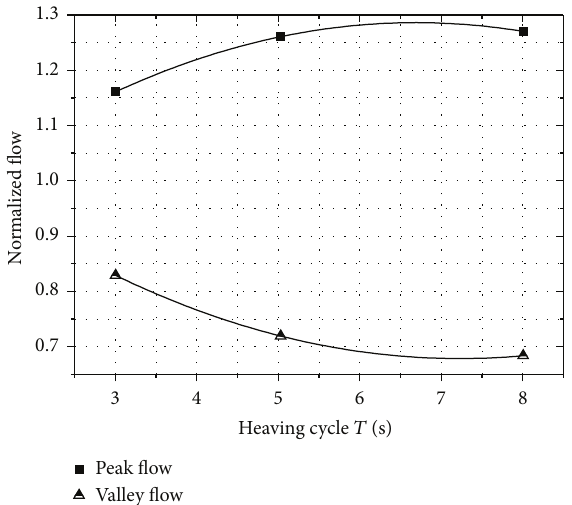
Figure 9: Peak and valley of flow changes of natural circulation with variable heaving cycle 𝑇 when heaving strength 𝑘 = 0.6 .